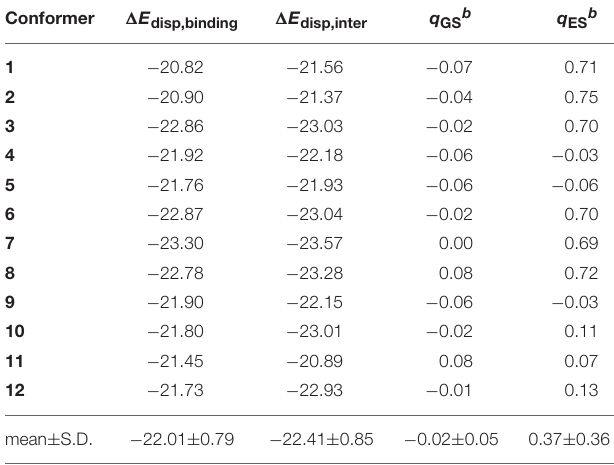
GS and excited q ES states for